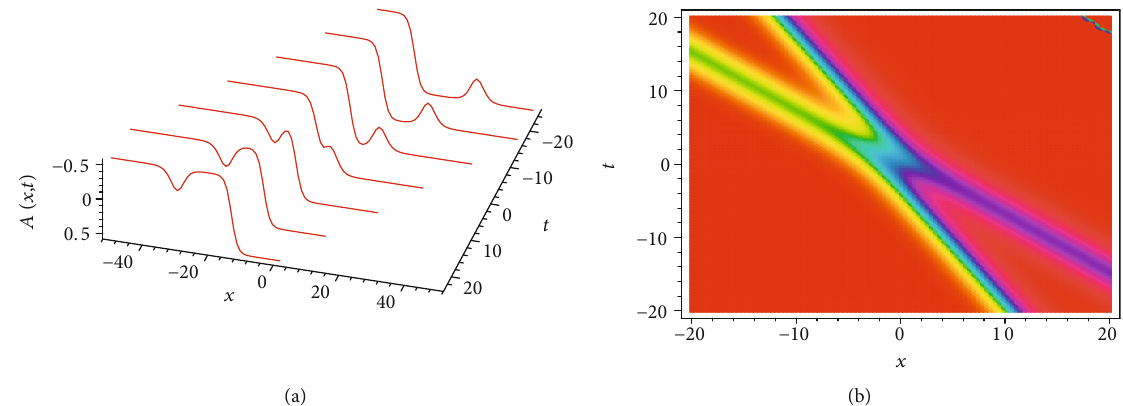
Figure 1: An interaction structure between soliton and kink for solution A in equations (70) and (72) is shown in (a) with the density plot in (b) where the parameters are selected as equation